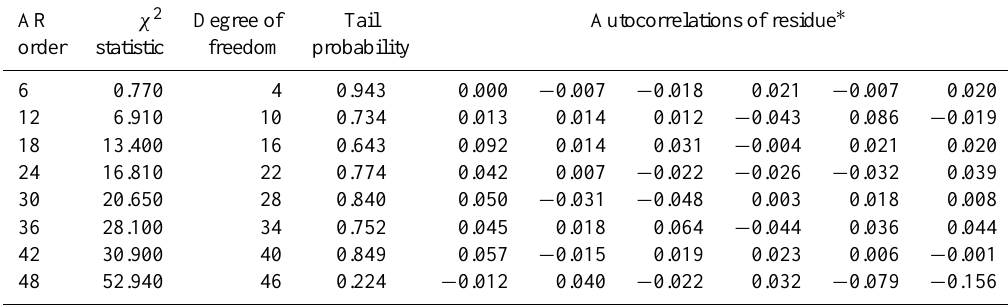
Table 2. Autocorrelation of the residuals of the conventional seasonal ARIMA model.